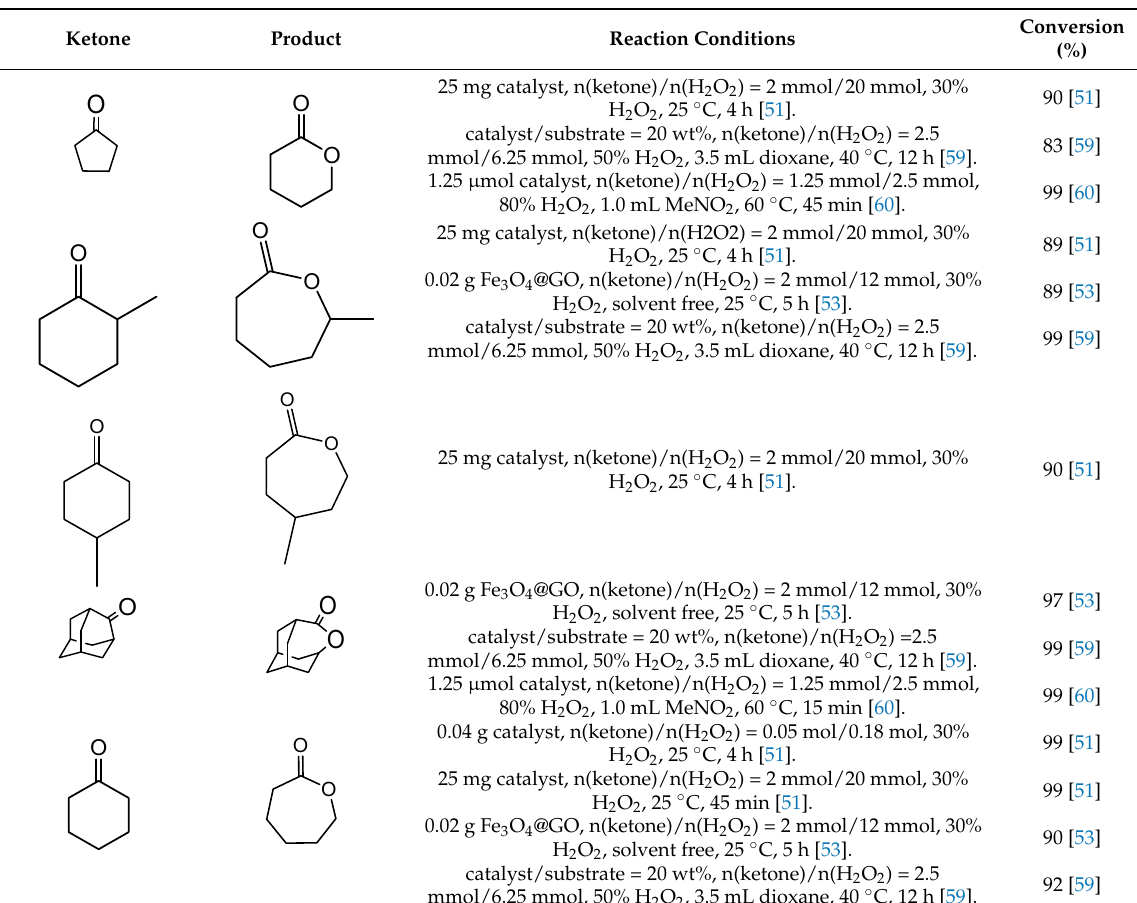
group are more likely to undergo the BV reaction than cyclic ketones with secondary carbon atoms adjacent to the ketone carbonyl group, and the selectivity for the formation of corresponding lactones is also higher. Table 5. Catalytic performances of different catalysts for the oxidation of cyclic ketones to lactones.